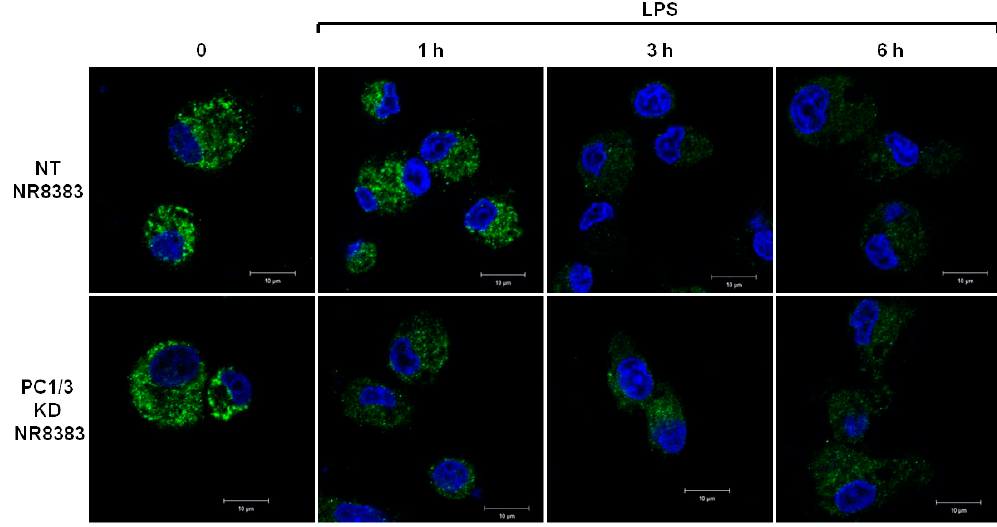
Figure 2. PC1/3 involvement in the control of TLR4 trafficking. NT and PC1/3 KD NR8383 macrophages were treated with 200 ng/mL of LPS for 0, 1, 3, and 6 h. Cells were then fixed, permeabilized and stained with an antibody directed against the extracellular domain of TLR4 (green). The nuclei were counterstained with Hoechst 33,342 (blue). Confocal microscopy analysis was then performed. Bar = 10 μ m.